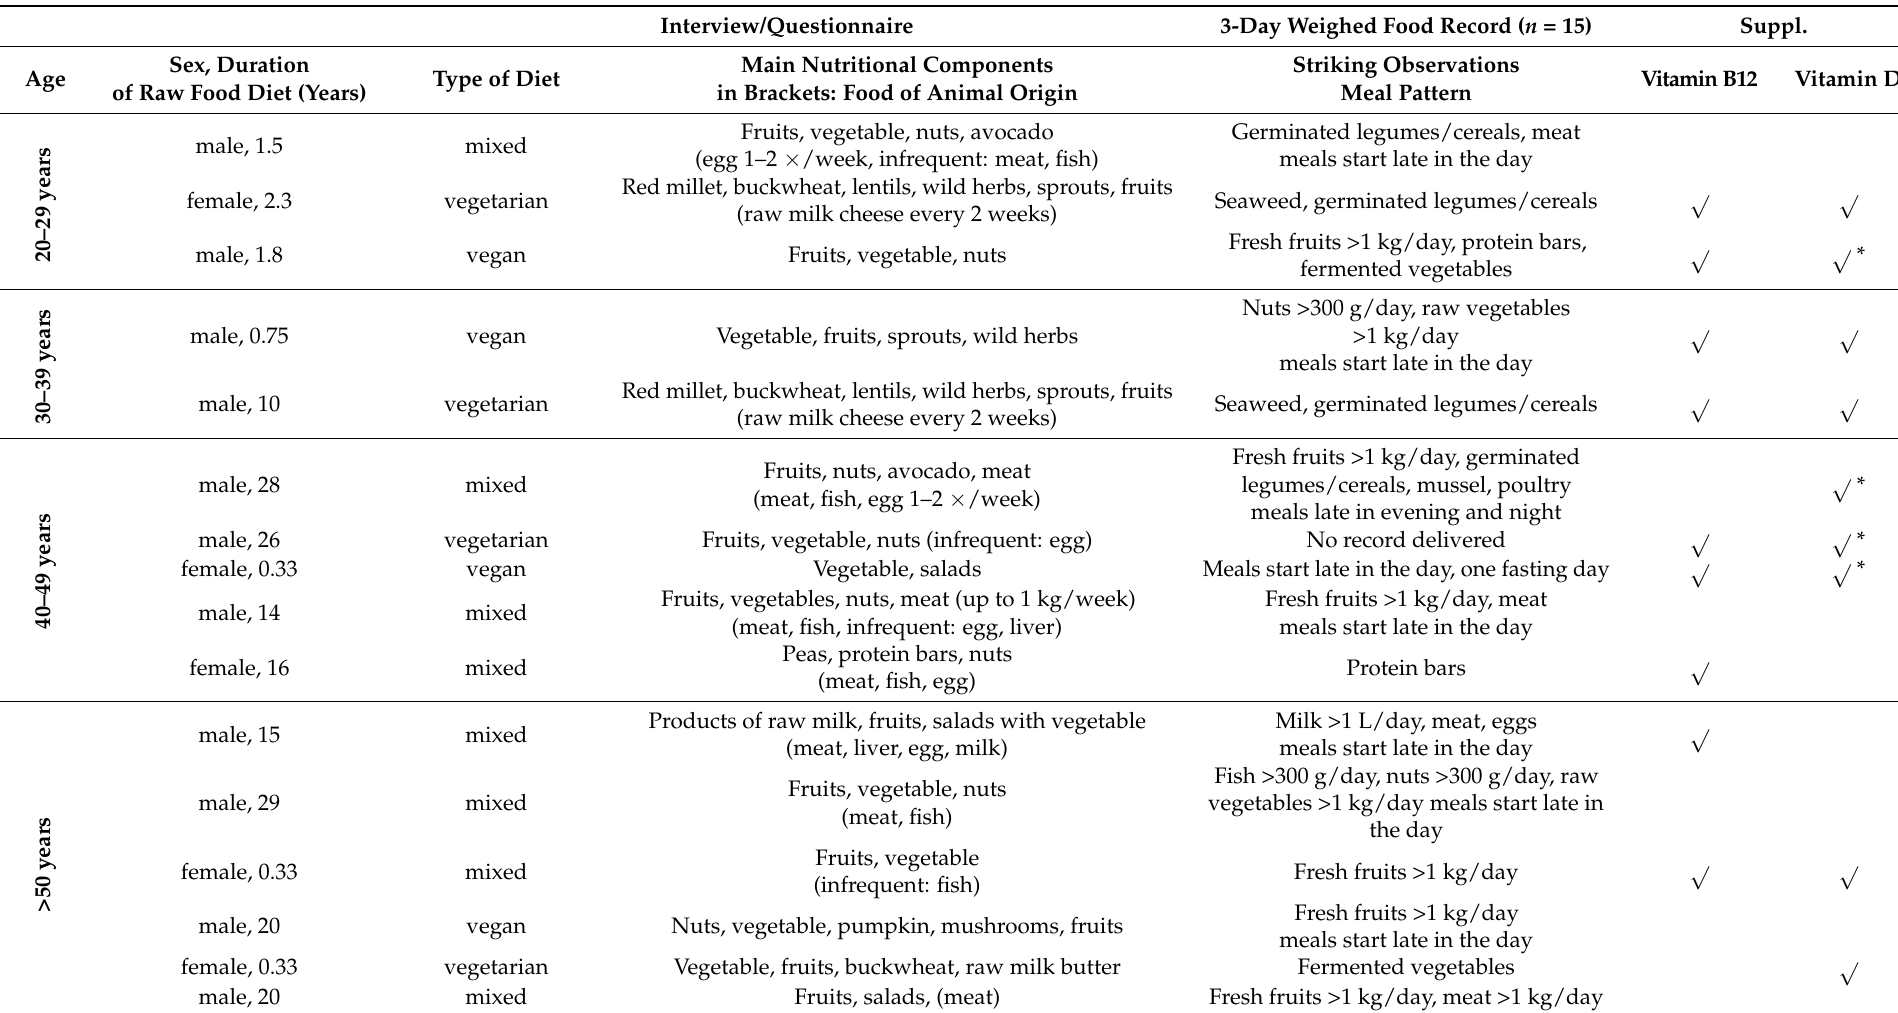
Table 1. Individual characteristics of the 16 strict raw food